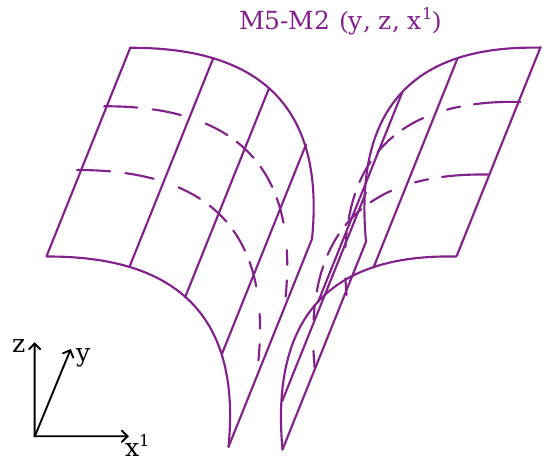
Figure 3 . The backreaction of the M5-M2 bound state, projected onto the space ( y, x 1 , z ) . The M2-branes pull the M5-branes, forming a furrow. The mechanism is similar to the formation of a Callan-Madacena spike in the D3-F1 brane